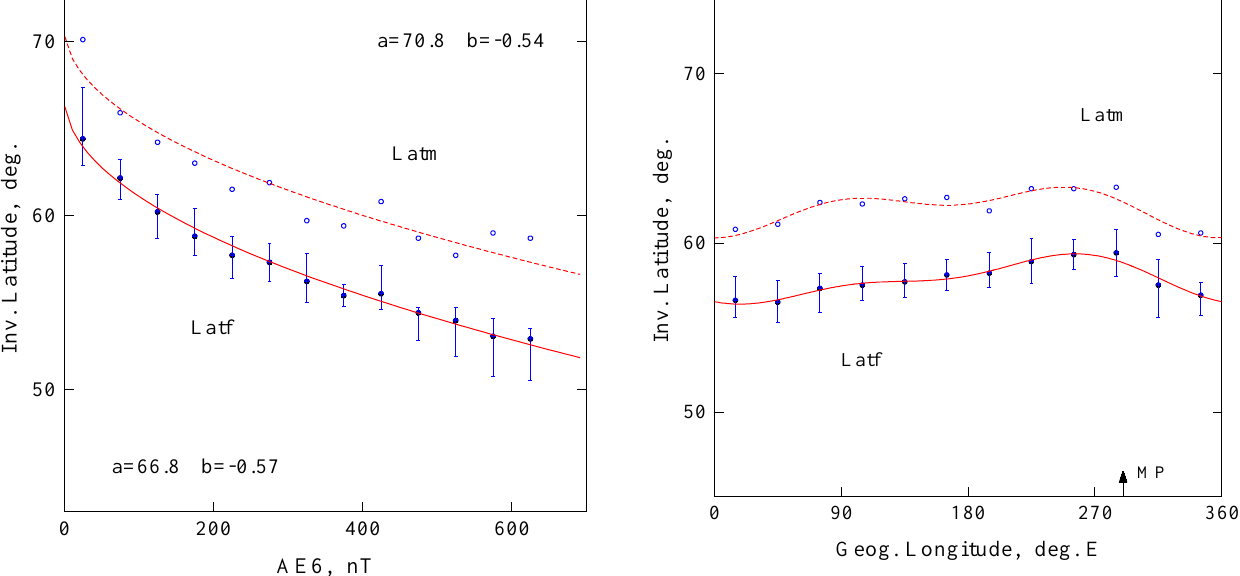
Fig. 4. Location of the polar cliff as function of geographic longi- Fig. 3. Location of the polar cliff as a function of geomagnetic ac- tude. The format of data presentation corresponds to that in Fig. 3, tivity. The AE6 index is indicated on the abscissa, the associated except that this time a combination of sin and cos functions has invariant latitudes of the equatorward (latf) and poleward (latm) been fitted to the median values. The analytic form of these regres- boundaries of the polar cliff on the ordinate. The median and the up- sion lines is given in Eq. (4). An arrow indicates the position of the per and lower quartiles of these latter parameters were determined geomagnetic pole (MP). Note that the results presented in this fig- for each 50nT-wide interval of the AE6 index. In case of latf, these ure refer to a geomagnetic activity level of AE6=250nT; see text are indicated by the blue dots and bars. In case of latm, only the for respective medians are shown (open blue circles). In both cases, the interquartile ranges are of the same order of magnitude (the mean interquartile ranges are 2.6 ◦ for latf and 3.7 ◦ for latm). Regression √ lines of the type latf, m = a + b AE6 were fitted to the median values (latf: solid red line; latm: dashed red line). The associated coefficients are given in the lower left-hand (latf) and upper right- hand (latm) corners, respectively. Note that only few data points are available for AE6 values larger than, say, 600nT; furthermore, that each median point has been given equal weight in the regression analysis; and finally, that a small part of the scatter is due to embed- ded variations with longitude and local time.